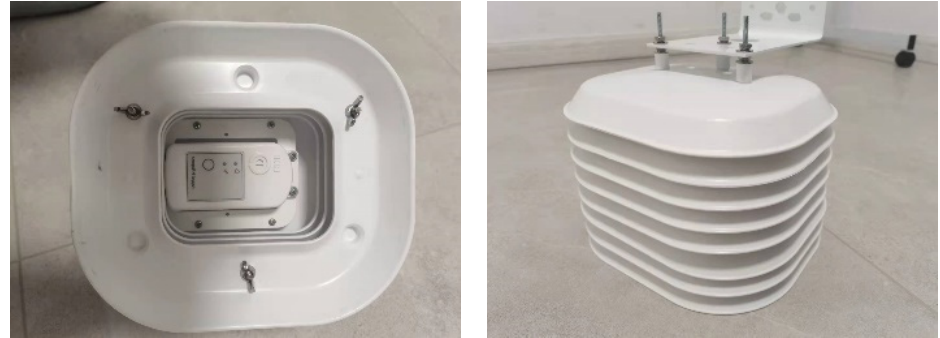
Figure 4. Temperature and relative humidity sensors for indoor ( left ) and outdoor ( right ) environments.